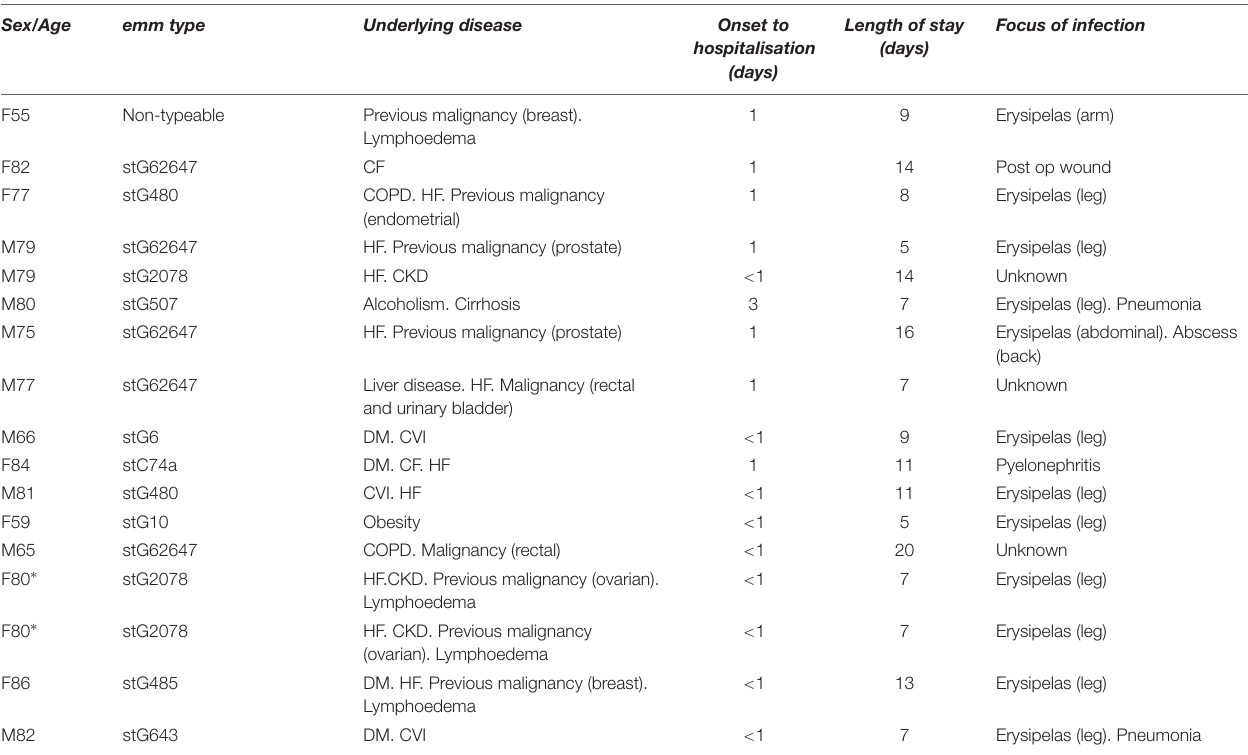
TABLE 1 | Clinical features of patients with Streptococcus dysgalactiae